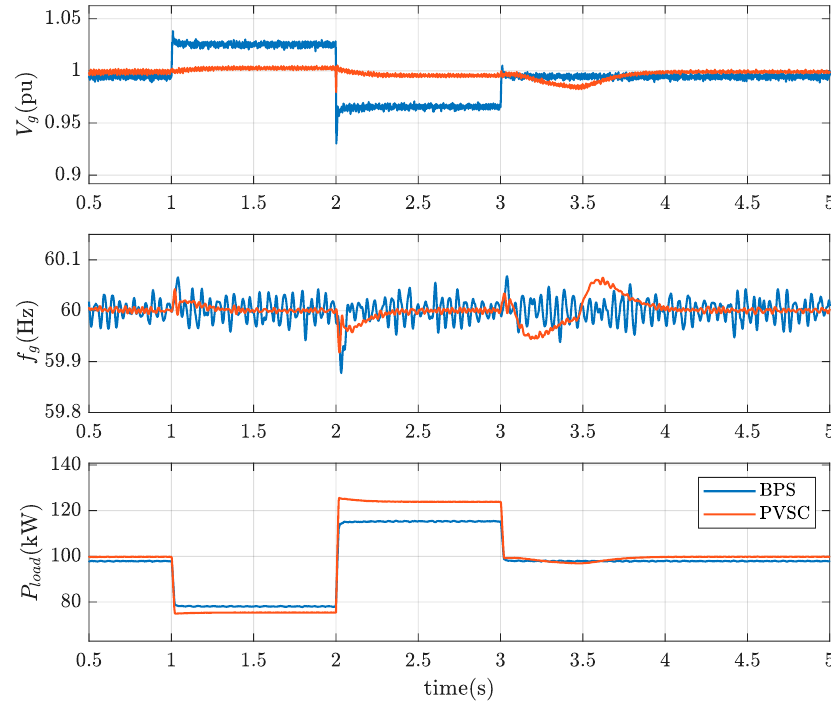
Figure 24. Stepwise load variation and weak integration to the grid.